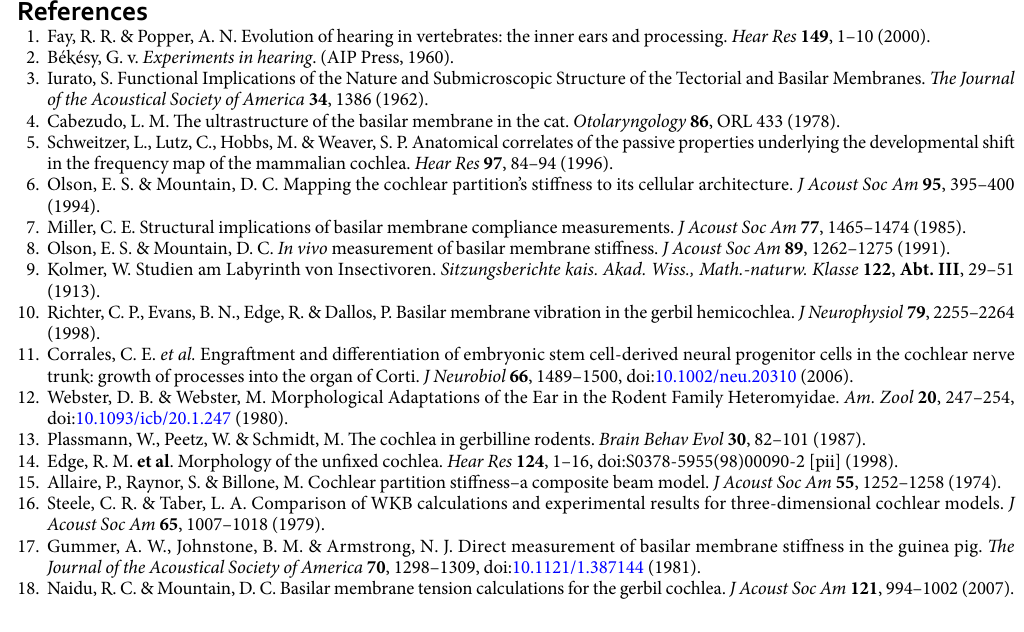
bined thickness t 1 + t 2 . The transverse deflection w is restrained at the bony PSL and SSL endpoints, since these are much stiffer than the BM in the transverse direction. However, the elasticity of the PSL and SSL may allow them to move in-plane in the radial direction X . This is modeled by restraining the in-plane displacement at the SSL end and adding an axial spring of constant k s at the PSL